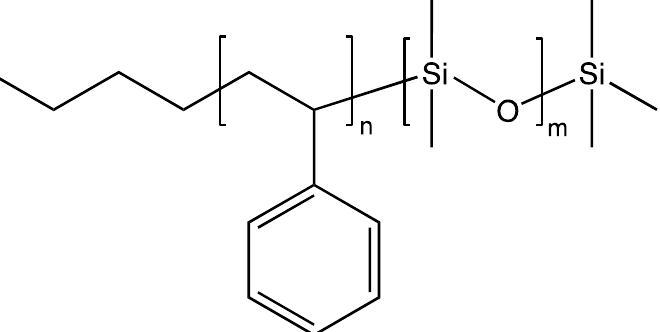
Figure 13. PS-b-PDMS after a single imprint cycle and annealing provides 60 nm features (Reprinted with permission from Ref. [173] Copyright 2007 Wiley).